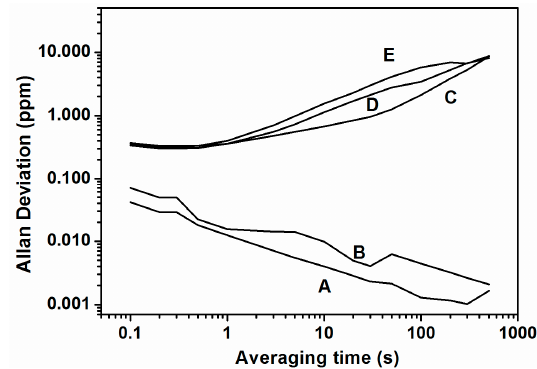
Figure 10. Allan deviation, exciting cantilever number 2 at different frequencies corresponding to the different peaks of Figure 2a: A , peak number 3 (1.10355 MHz); B , peak number 2 (1.05494 MHz); C , peak number 1 (1.06473 MHz); D , peak number 4 (1.0733 MHz); E , peak number 5 (1.09819 MHz).